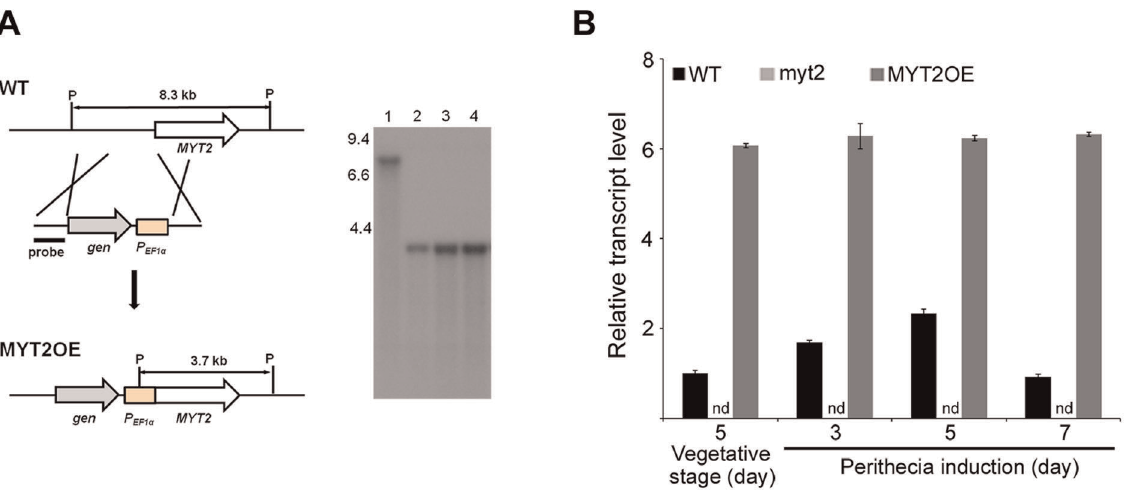
Figure 2. MYT2 overexpression. (A) The MYT2 promoter region was replaced with the EF1 a promoter. The left and right panels show the strategy of MYT2OE strain construction and Southern hybridization, respectively. In the blot, lane 1 and lanes 2–4 represent the wild-type strain and the MYT2 - overexpressed mutants, respectively. (B) Expression of MYT2 in the wild-type, MYT2 deletion, and MYT2 overexpression strains. MYT2 transcript accumulation was analyzed by quantitative real time-PCR (qRT-PCR) during the vegetative and sexual induction stages. WT, wild-type strain Z-3639; MYT2OE, transgenic strain where the MYT2 promoter region was replaced with the EF1 a promoter; P, Pst I. The sizes of DNA standards (kb) are indicated to the left of the